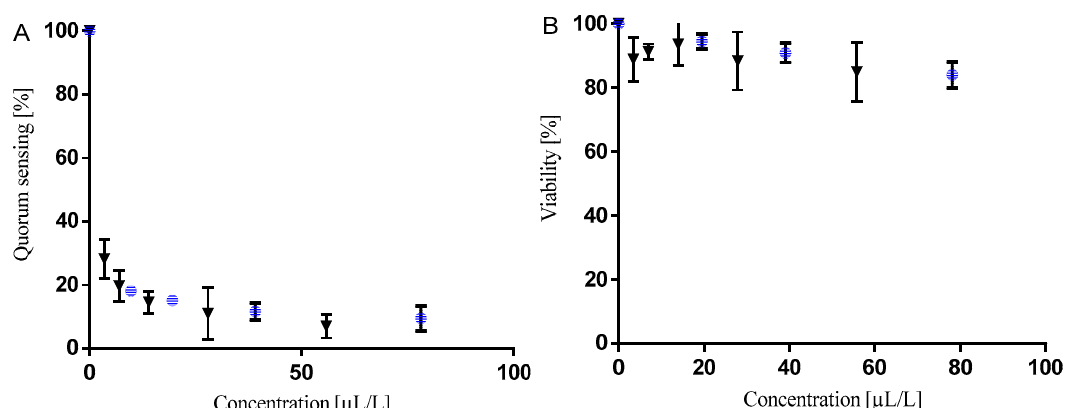
Figure 4. Dose-dependent e ff ect of lemongrass essential oil (blue circle) and citral (black triangle) on